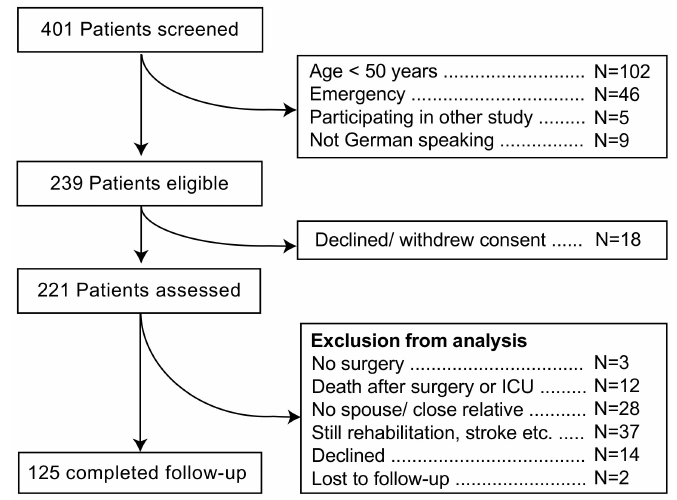
Figure 1. Patients’